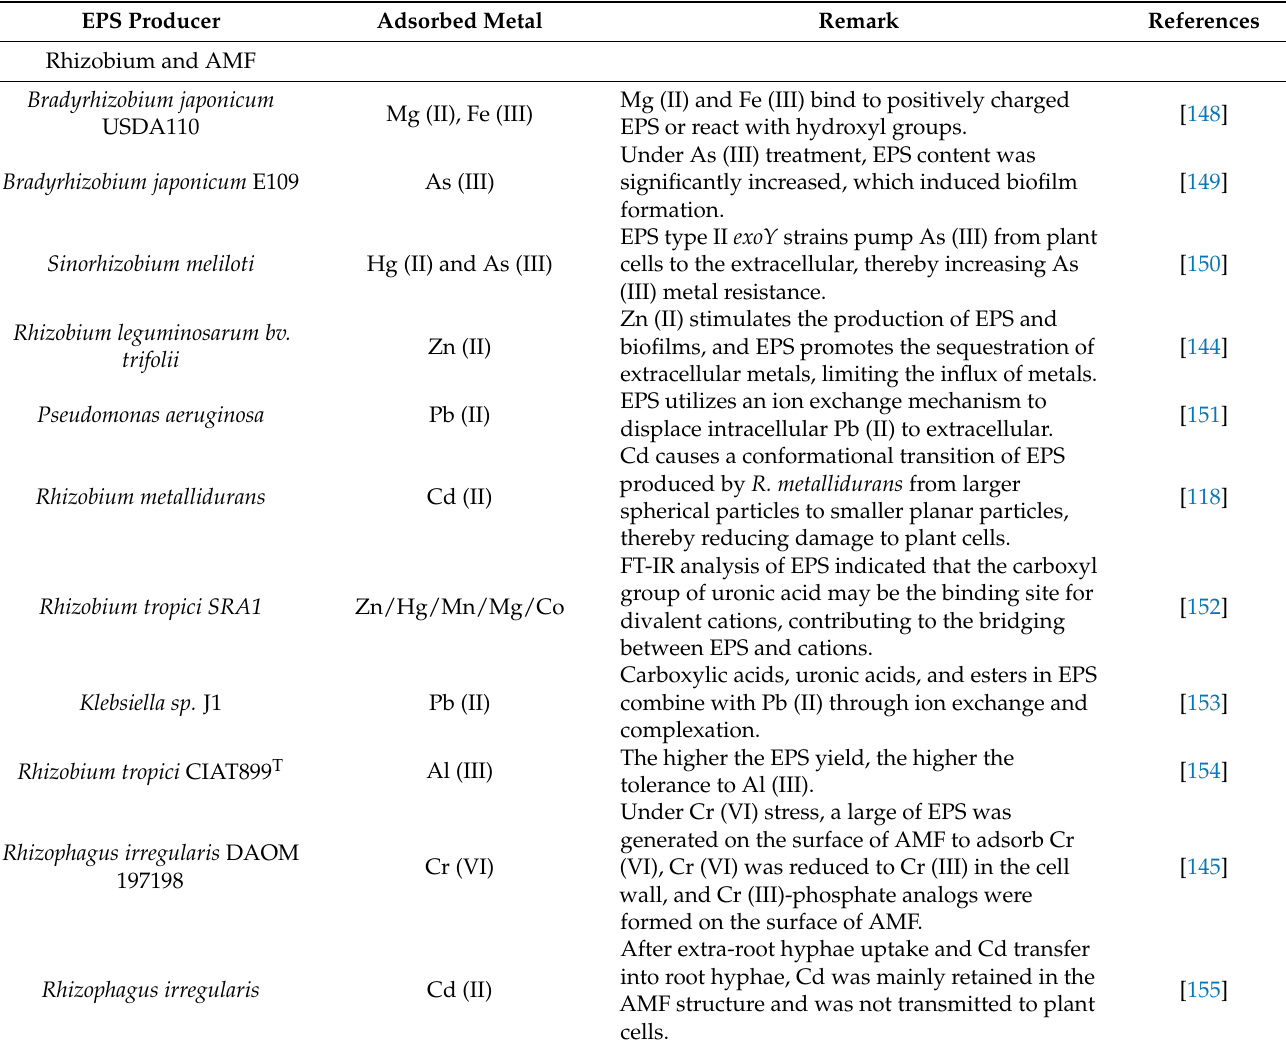
Table 2. Metal-binding potential of EPS produced by Rhizobium and